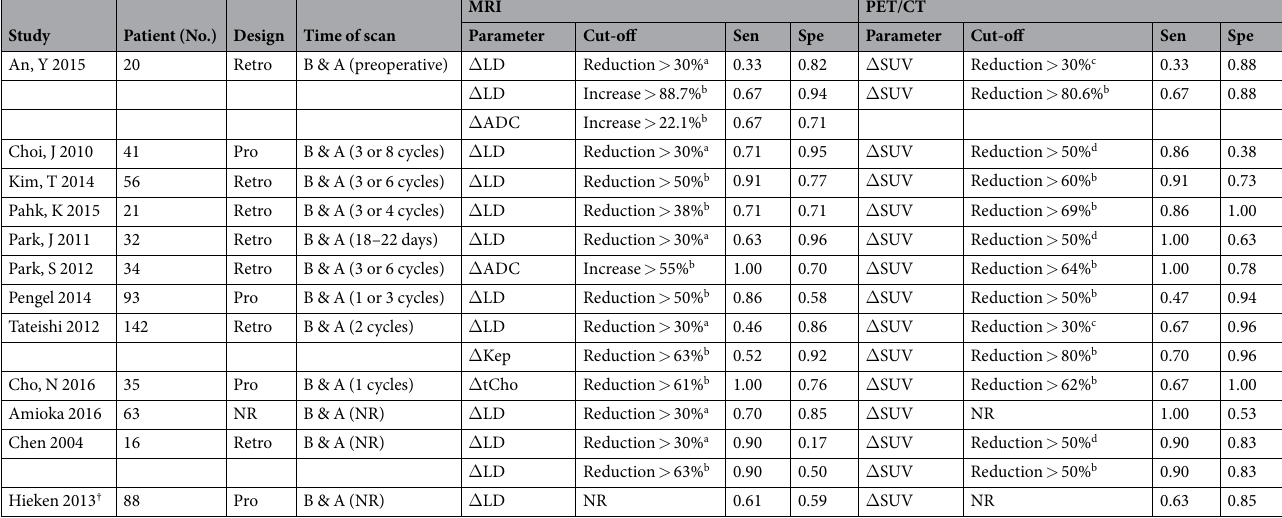
Table 2. Absolute numbers of the included studies. a Cut-off set by pre-specified RECIST criteria; b cut-off set by ROC analysis; c cut-off set by pre-specified PRECIST criteria; d cut-off set by pre-specified EORTC criteria; B & A, at baseline and after NAC; Pro, prospective; Retro, retrospective; NR, not reported; Δ LD, change in longest diameter; Δ ADC, change in apparent diffusion coefficient; Δ Kep, change in transfer constant; Δ tCho, change in total choline-containing compounds; Δ SUV, change in standardised uptake values. † Study assessed axillary lymph node response to